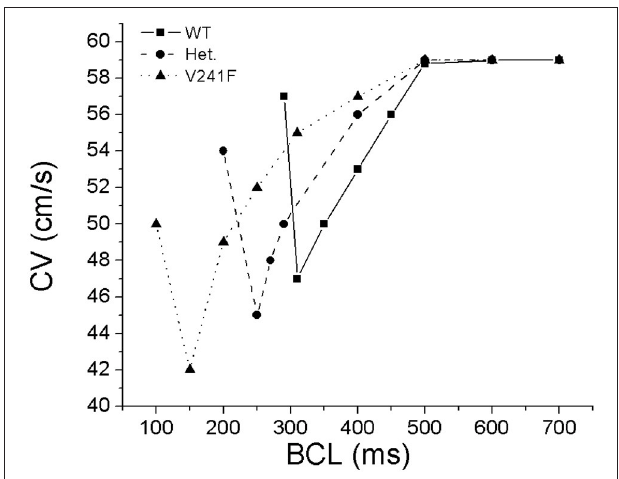
FIGURE 2 | Conduction velocity restitution curves obtained from a cable shape mesh by pacing at the left side of the mesh for 100 time under WT, intermediate (notified by Het.), and pure V241F mutation